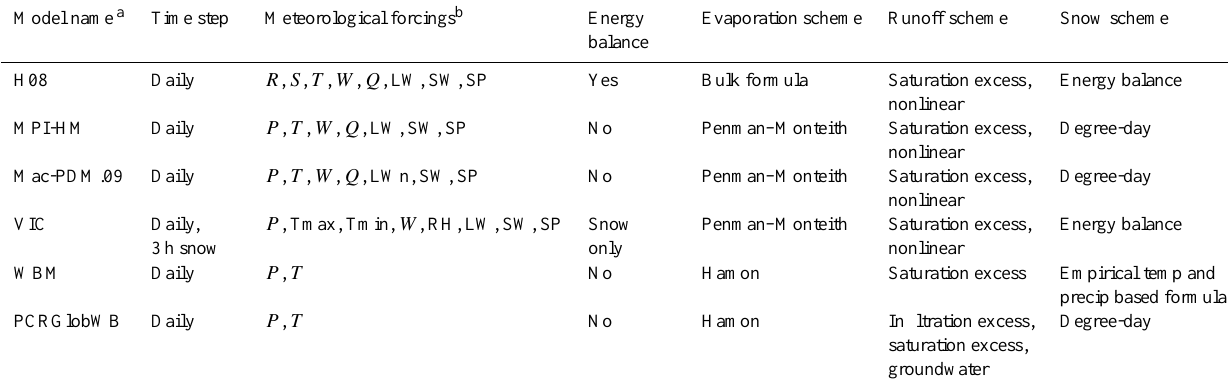
Table A1. Global hydrological models’ main characteristics (after Prudhomme et al., 2014). Model name